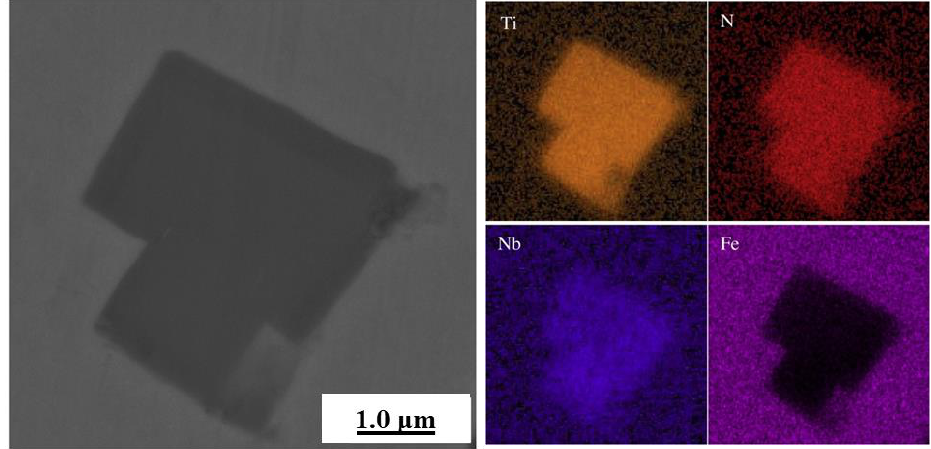
Figure 7. Morphology and element distribution of (Ti, Nb)N precipitation in Sb-containing weath- ering steel [66]. Reproduced with permission of Elsevier, copyright